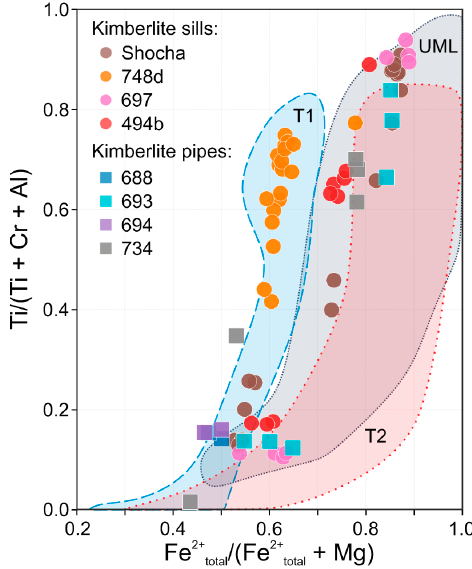
Figure 10. Ti/(Ti + Cr + Al) vs Fe 2+total /(Fe 2+total + Mg) variations of spinel grains from the